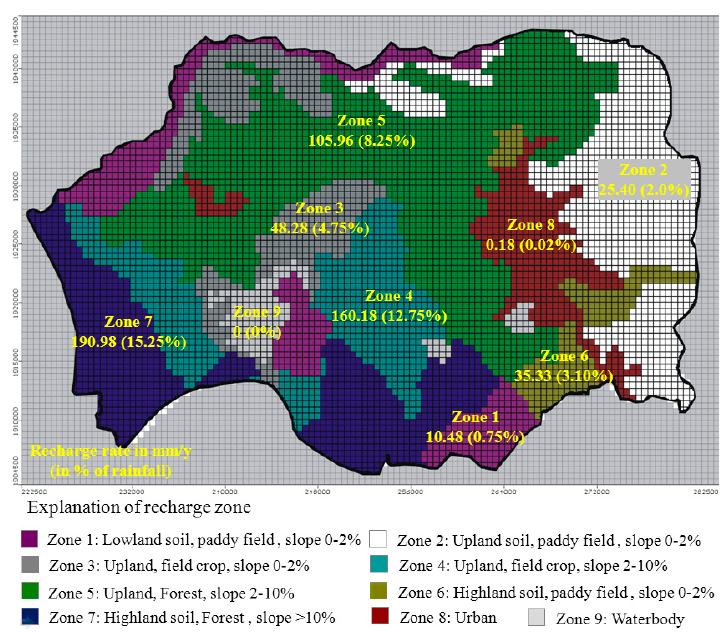
Figure 11. Recharge zones, their properties for the HELP3 model, and recharge rates for SEAWAT models.